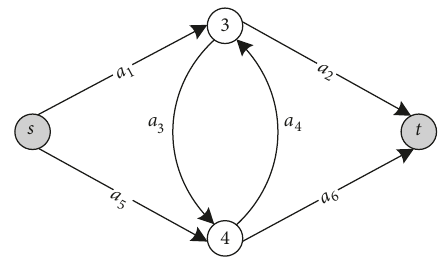
Figure 1: A multistate two-terminal